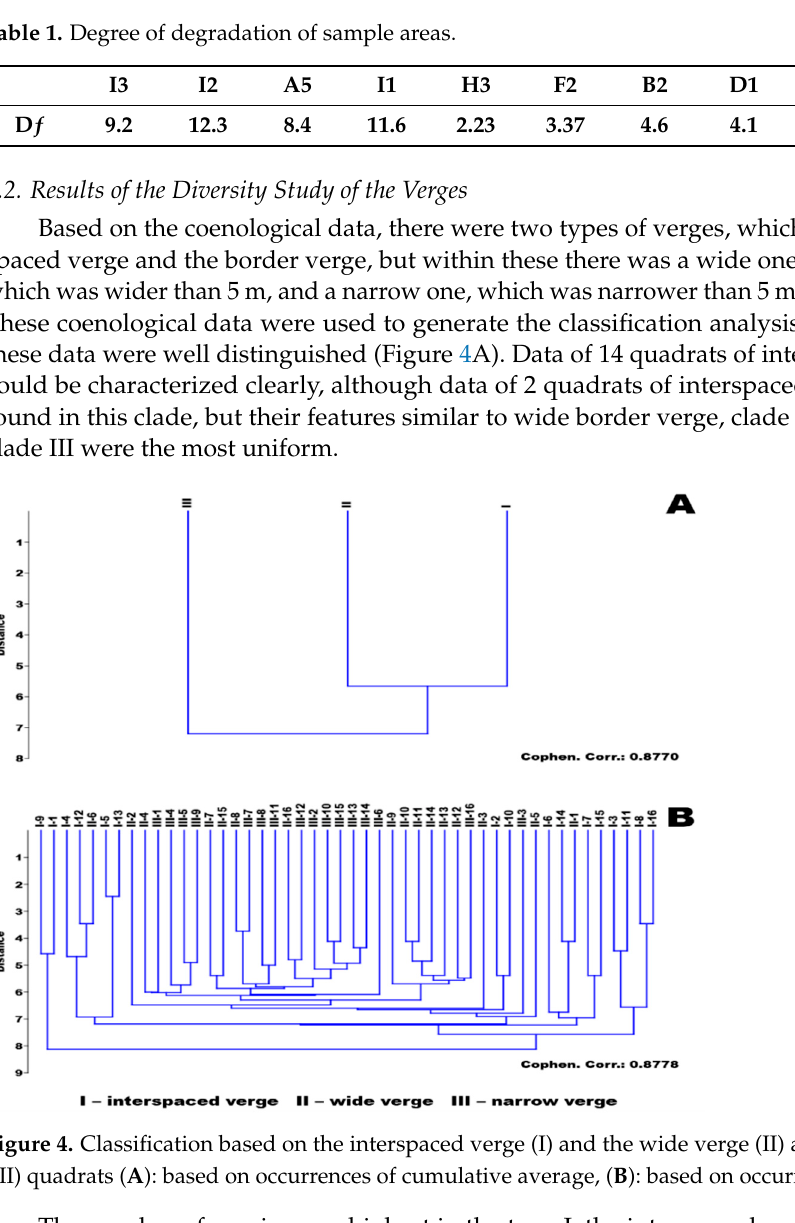
Figure 5. Diversity based on the interspaced verge (I) and the wide verge (II) and narrow verge (III) quadrats.